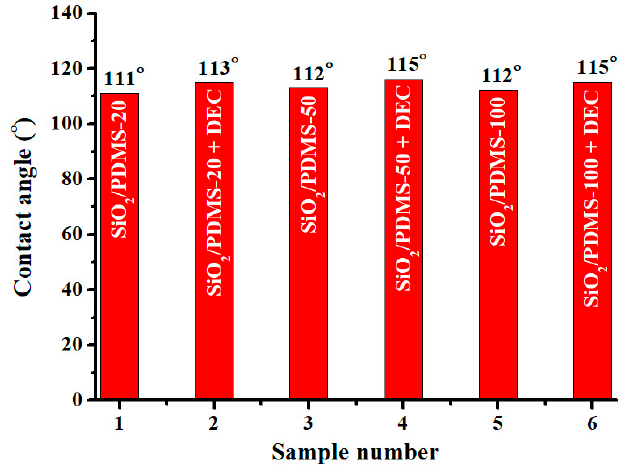
Figure 5. Contact angles of wetting of modified silicas.